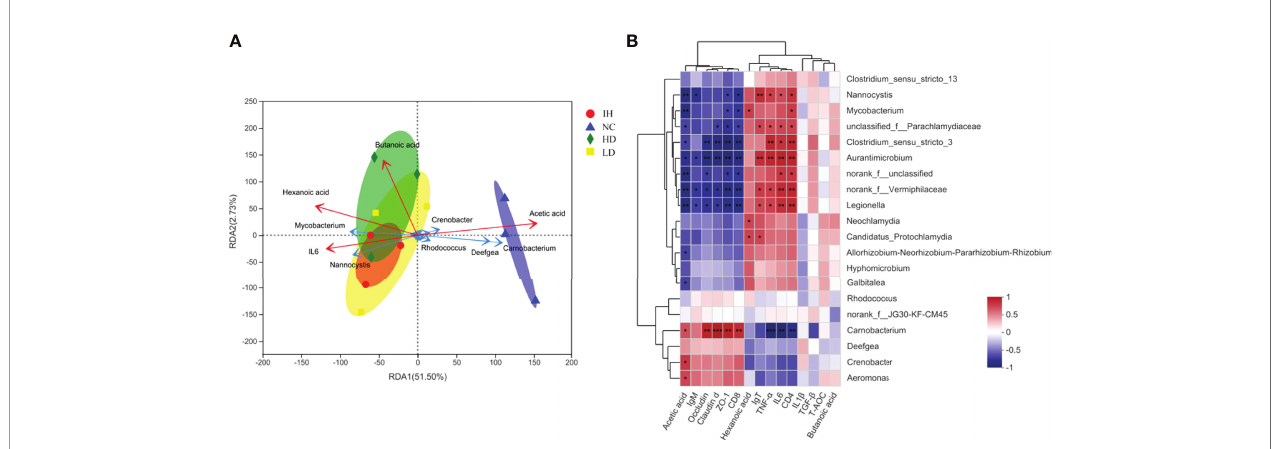
FIGURE 7 | RDA and Spearman correlation analysis. (A) Redundancy analysis of key factors responding to top 20 gena; (B) Spearman correlation between key factors and the top 20 gena. The symbol "*,** and ***" indicated the signi fi cance between the key factor and genus at P ≤ 0.05, P ≤ 0.01 and P ≤ 0.001,